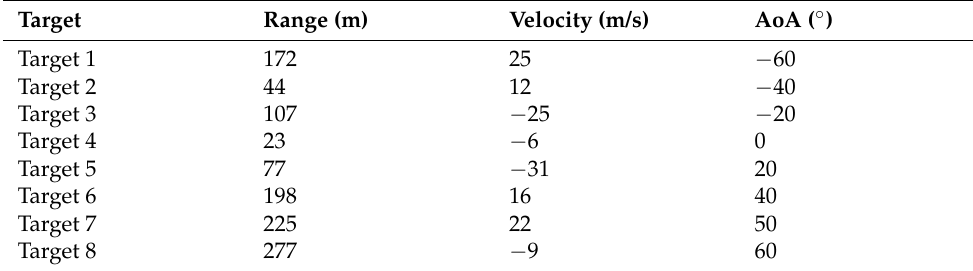
Table 2. Target parameters.